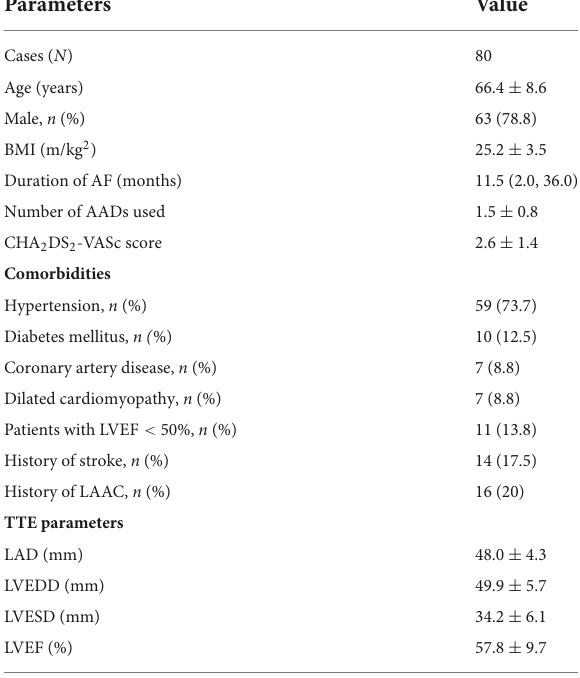
TABLE 1 Demographic data of the patients enrolled in this